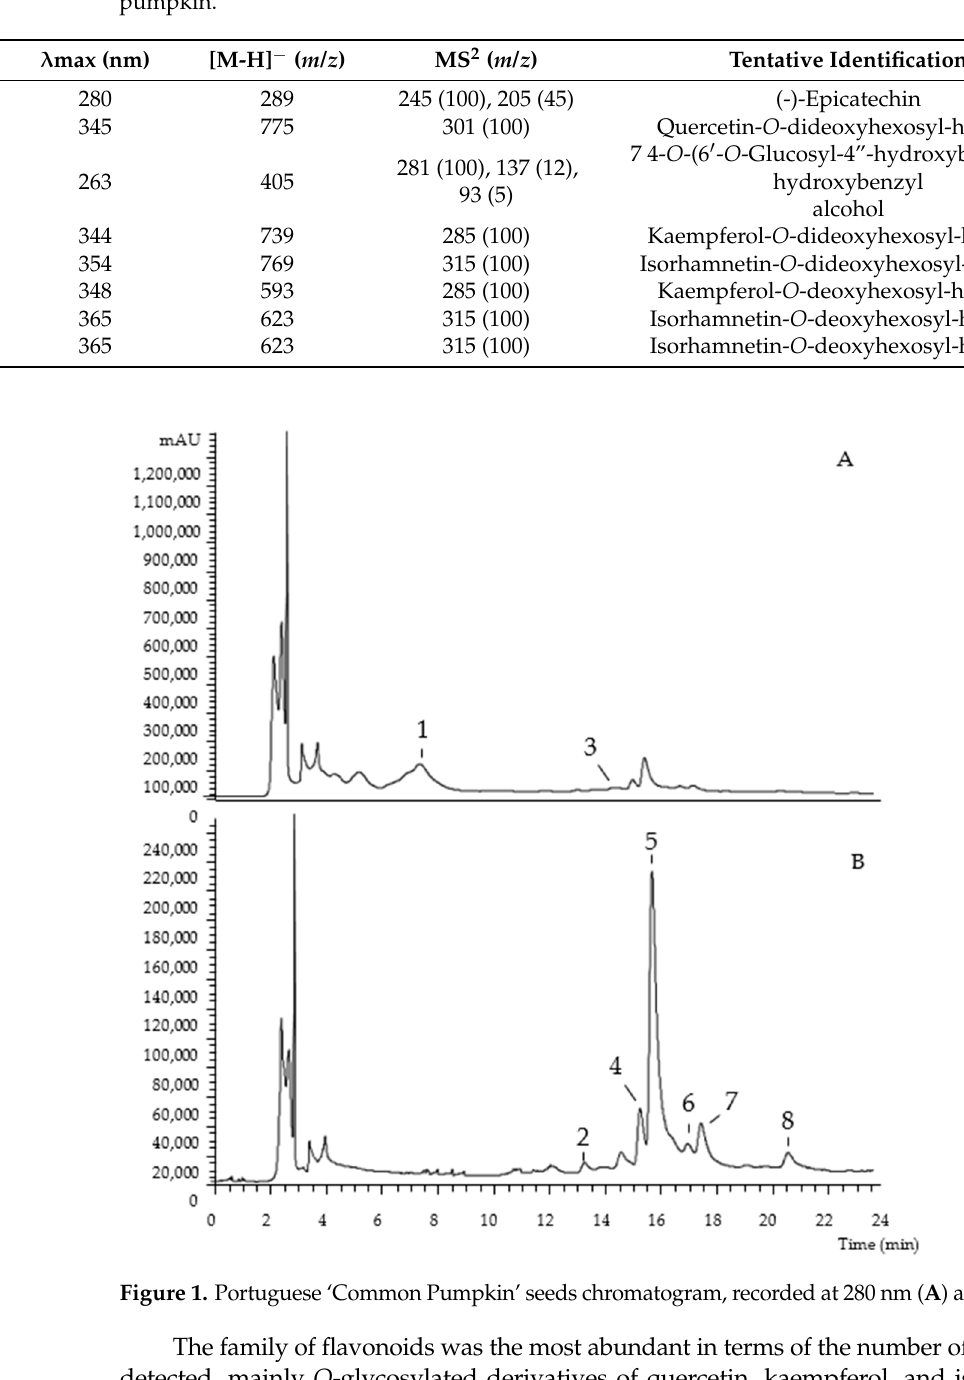
Table 1. Phenolic compounds characterized by HPLC-DAD-ESI/MS in the different samples of pumpkin.